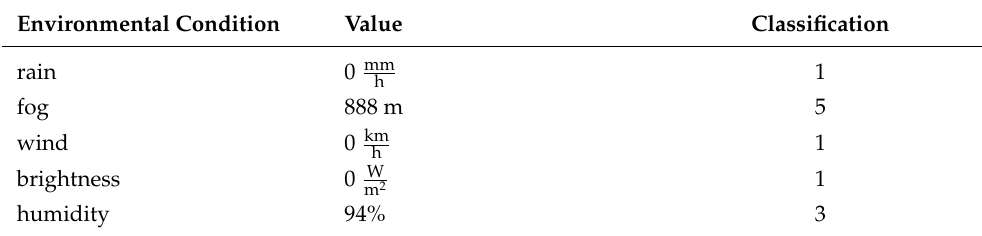
Table 6. Environment table for the test example with a 2D LiDAR sensor.